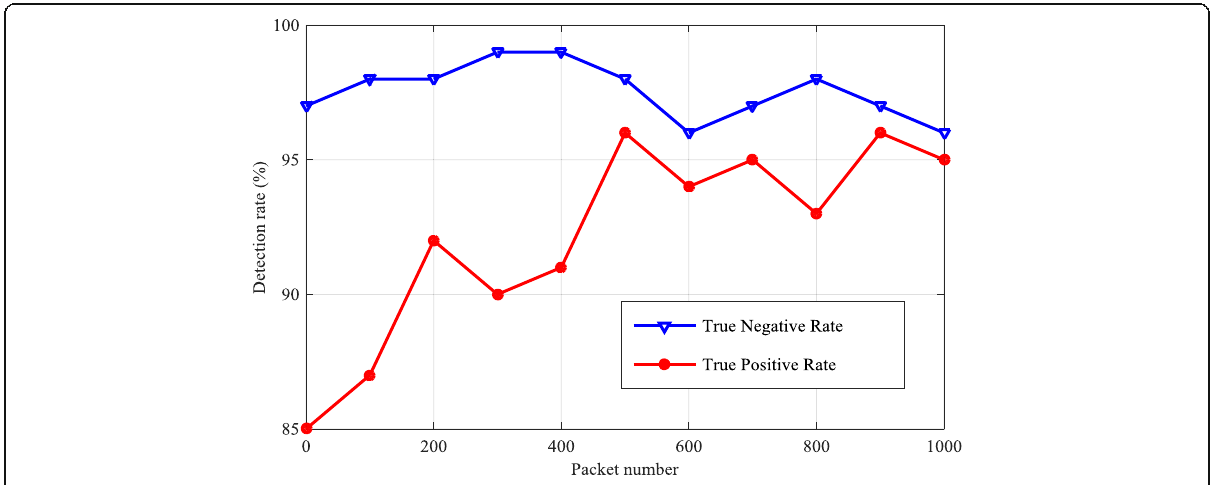
Fig. 15 Impacts of packet quantity on detection